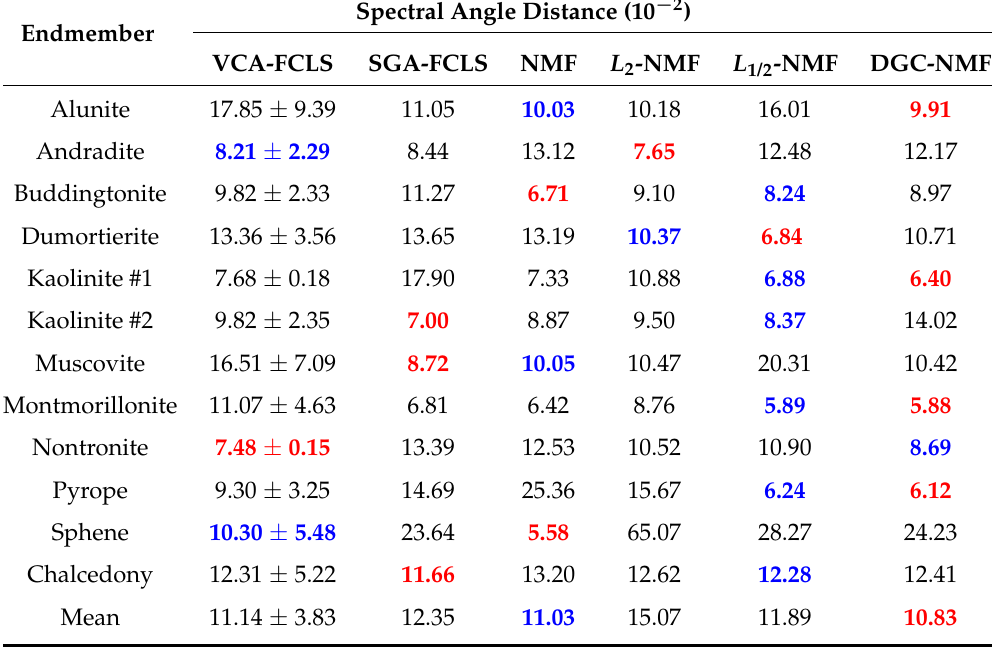
Table 4. The spectral angle distance and their standard derivations of algorithms on the Cuprite data. Numbers in bold and red color represent the best results; numbers in bold and blue color represent the second-best